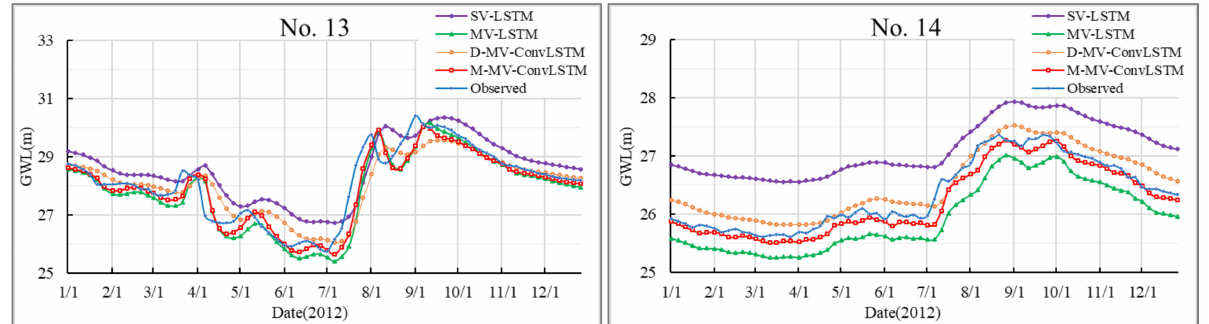
Figure 7. Modeling simulation results obtained at certain wells in the four experiments.